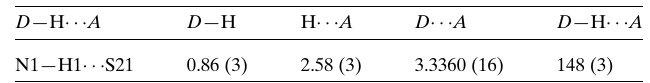
Table 2 Hydrogen-bond geometry (A˚ , (cid:2) ) for 2